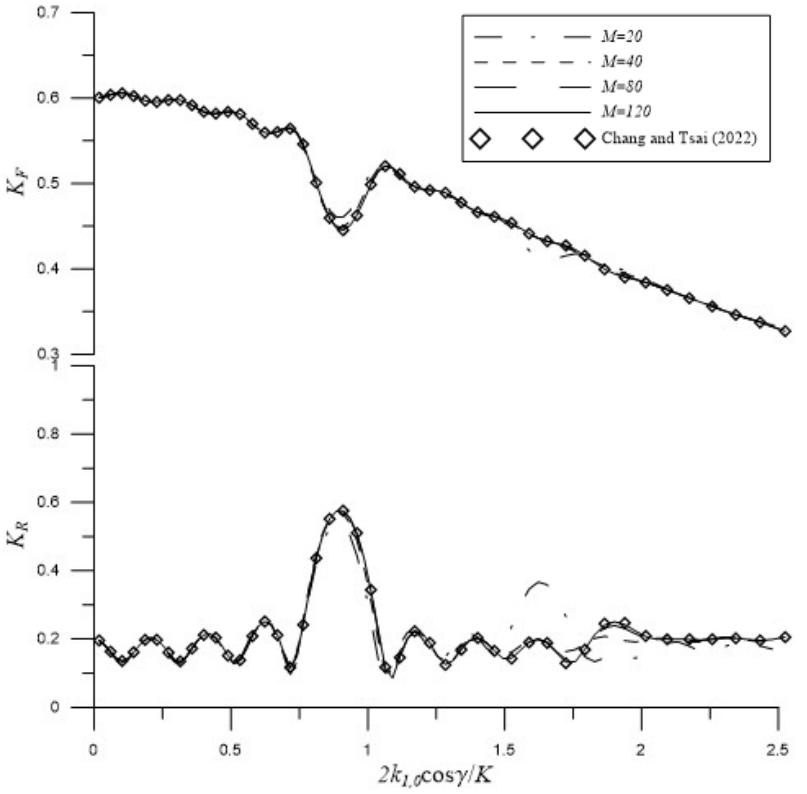
2 cos k K γ for 1,0